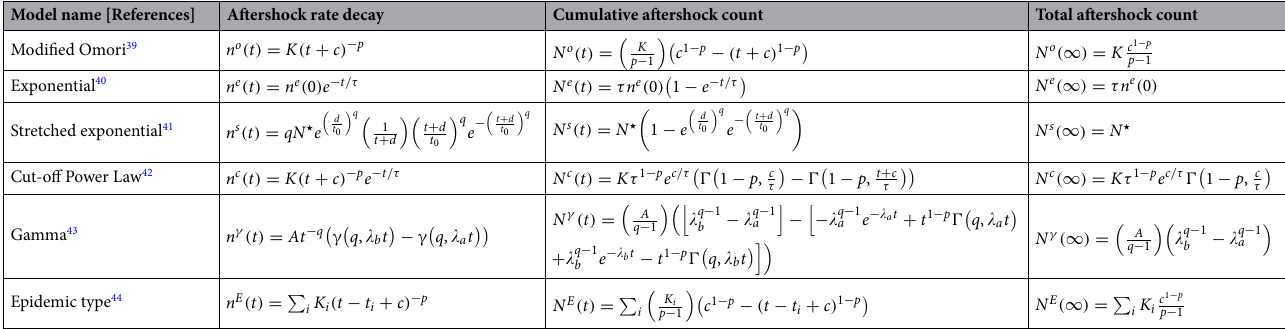
Table 1. Aftershock models proposed for tectonic earthquakes. For each model we provide an expression for the aftershock rate function n ( t ) , the cumulative aftershock count function N ( t ) , and the total number of aftershocks N ( ∞ ) . Corresponding references are also provided for each model. Note that γ ( a , x ) and Ŵ( a , x ) are the lower and upper incomplete gamma functions, respectively. Superscripts are used to denote the aftershock decay model